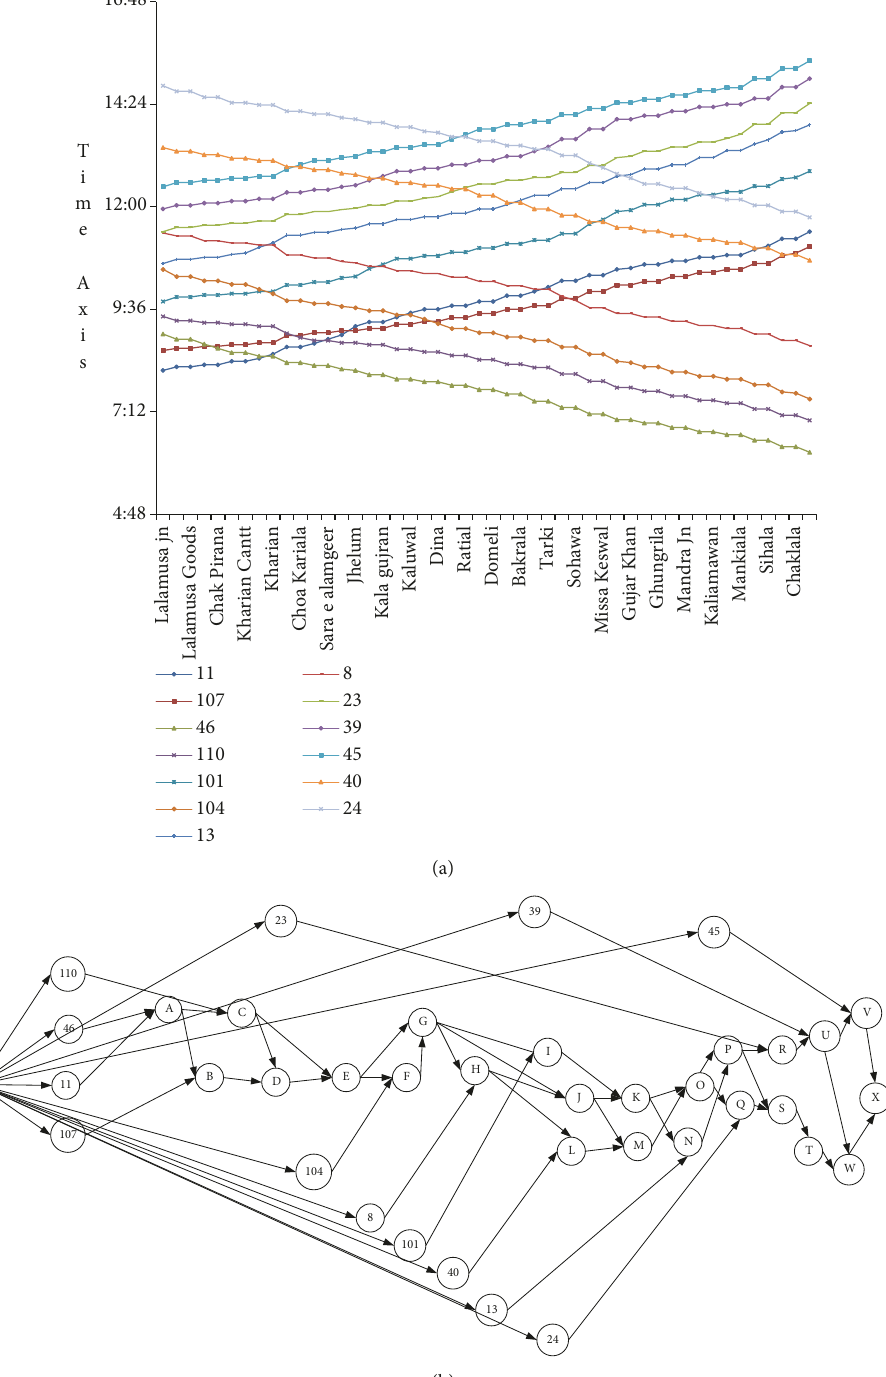
Figure 6: (a) Timetable with conflicts for track segment from Rawalpindi to Lalamusa. (b) Network formulation of the selected train